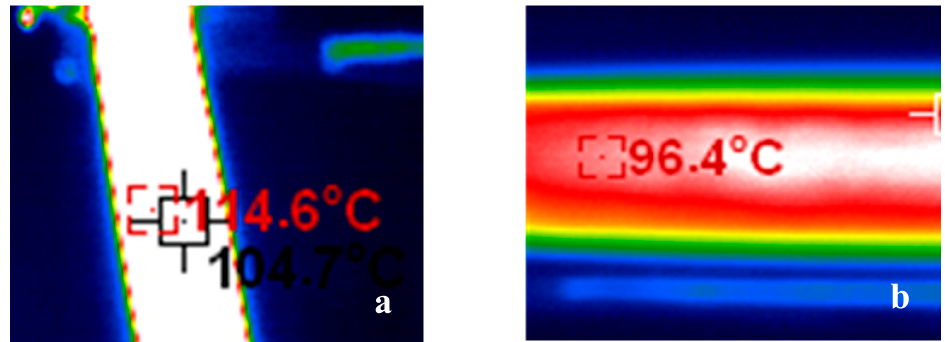
Figure 10. Infrared thermal imaging of CFRE plate before and after saturated hygroscopicity. ( a ) Original sample, and ( b ) saturated hygroscopic sample.